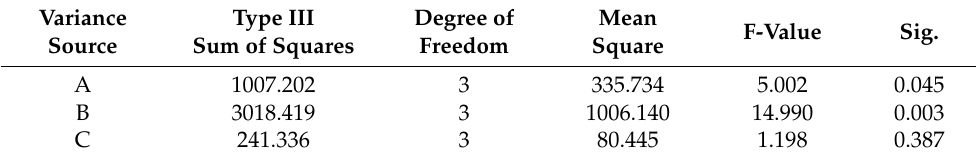
Table 10. The results of variance analysis for impermeability performance